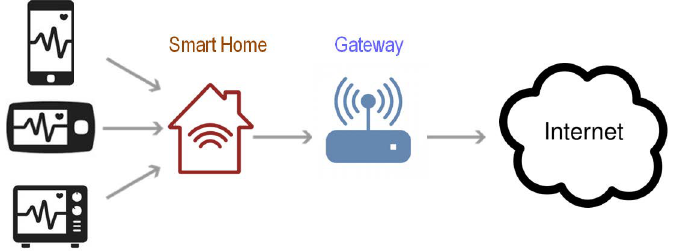
Figure 1. A smart home with electrocardiogram (ECG) monitoring